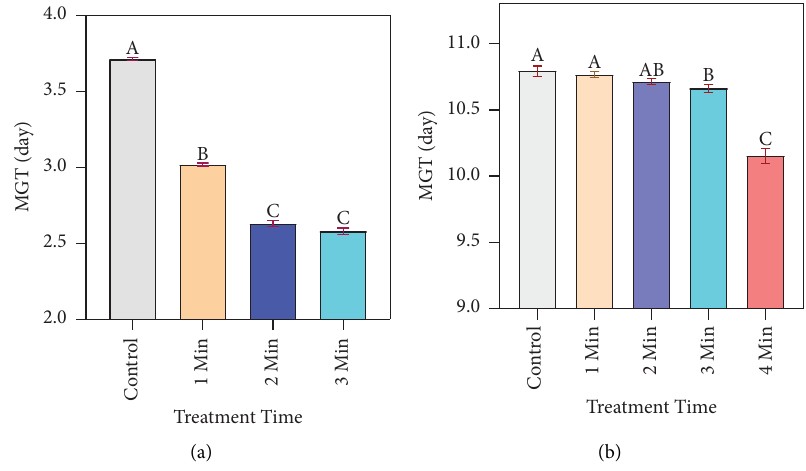
Figure 7: Infuence of CAPP exposure on the mean germination time of (a) radish and (b) carrot.